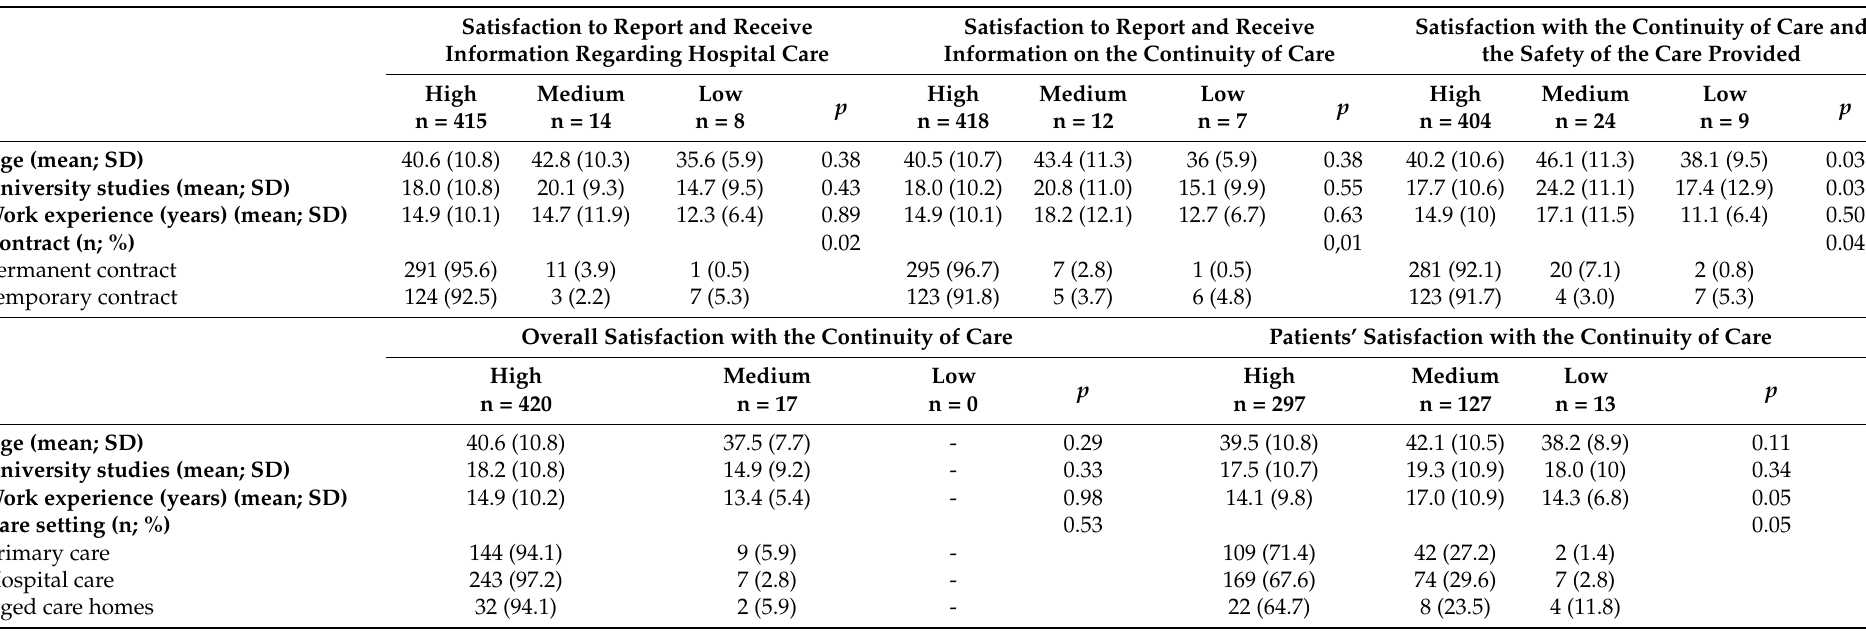
Table 2. Nurse satisfaction with the current continuity of care model and related